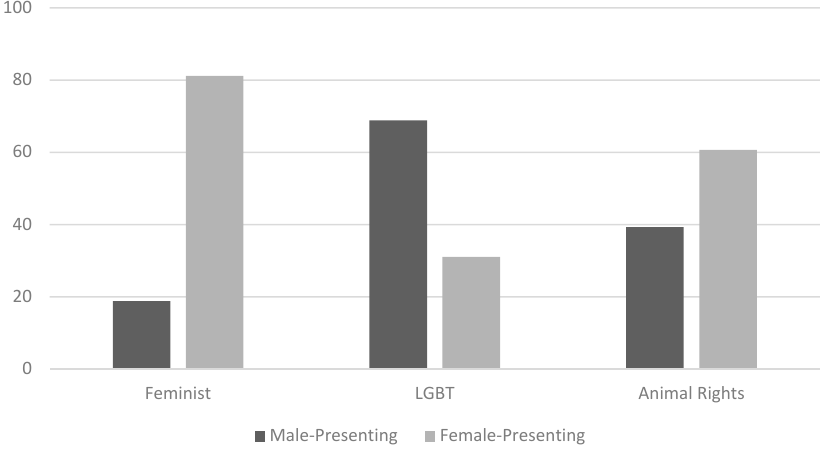
Figure 1. Distribution of Gender.